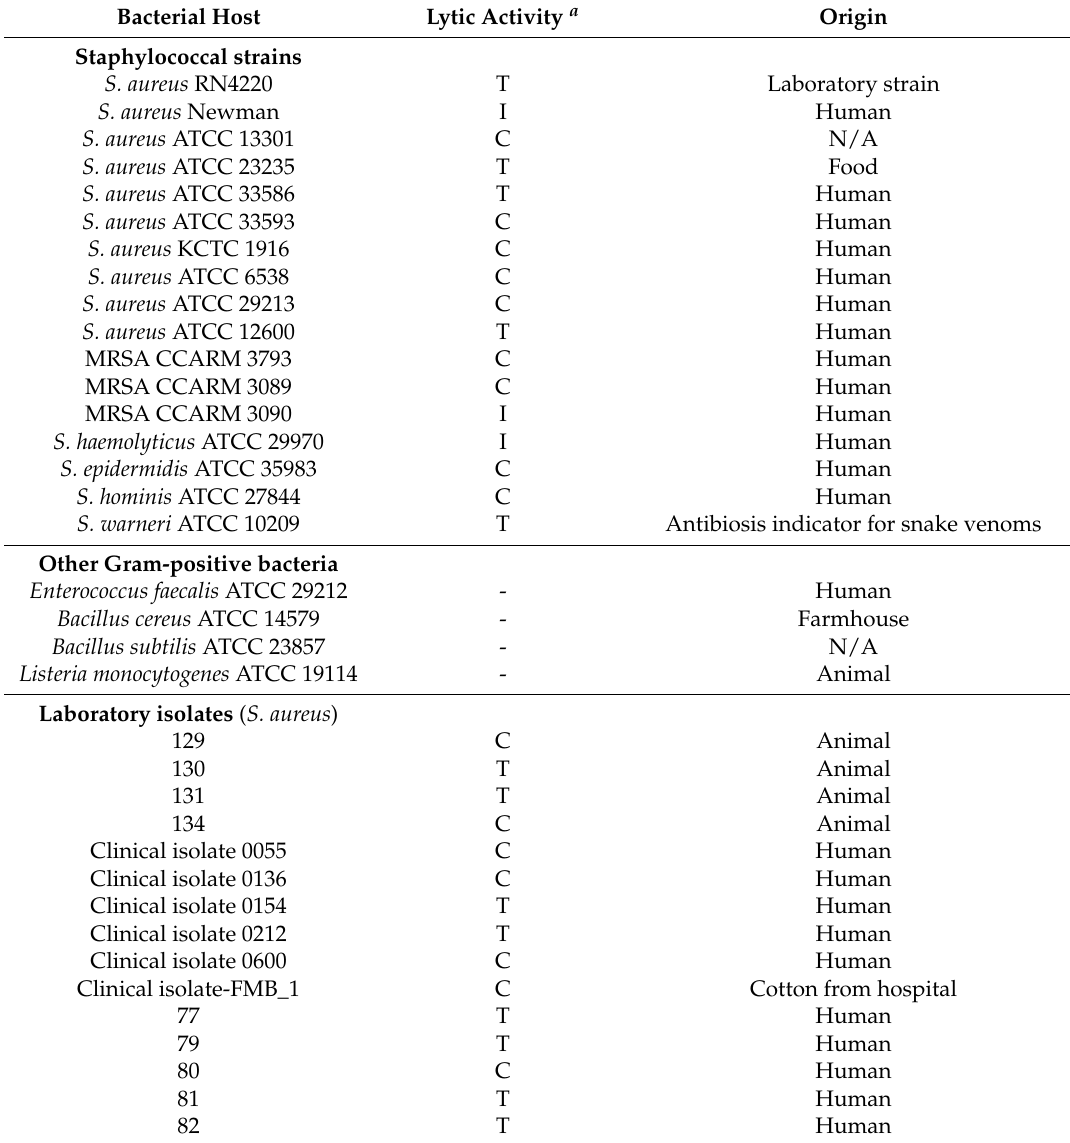
Table 1. The antimicrobial spectrum of phage